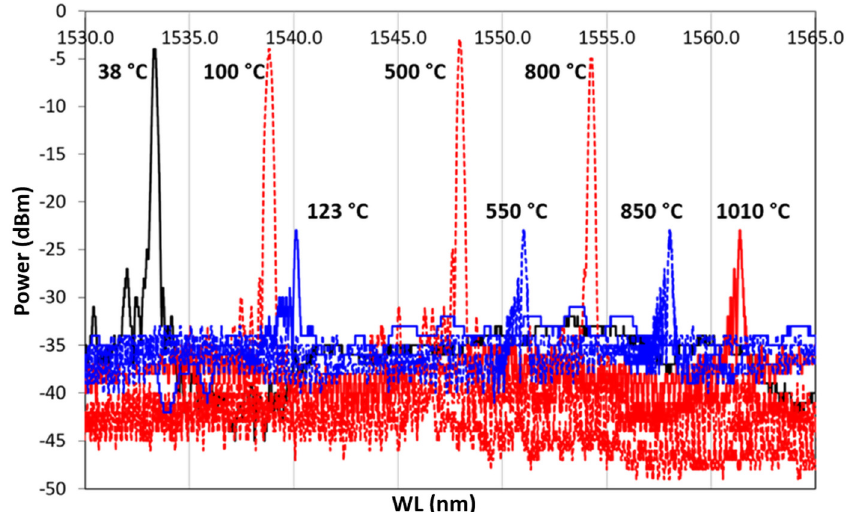
Figure 11. Second Heating/cooling cycle. A dotted red line represents the heating ramp, from 38 to 1010 ◦ C; the dotted blue line represents the cooling ramp, from 1010 to 123 ◦ C. A continuous line represents the reference temperature, in black the RT, that is, the initial point of the cycle, in red 1010 ◦ C, and in blue the last recorded spectrum, at 123 ◦